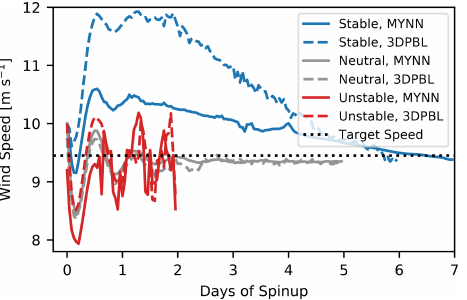
Figure 1. Hub-height wind speed at the center of each domain dur- ing spinup in the idealized turbine-free simulations. The last 24h of each simulation is taken as the performance period for the NWF simulations.